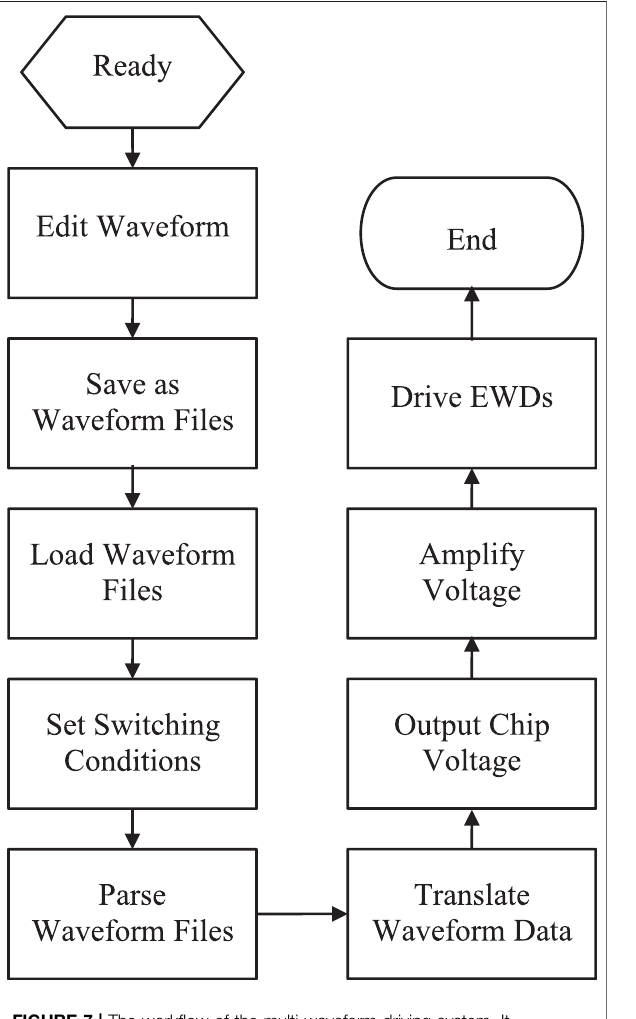
FIGURE 7 | The work fl ow of the multi waveform driving system. It includes of waveform editing, waveform saving, waveform loading, conditions setting, waveform parsing, waveform translating and voltage amplifying.